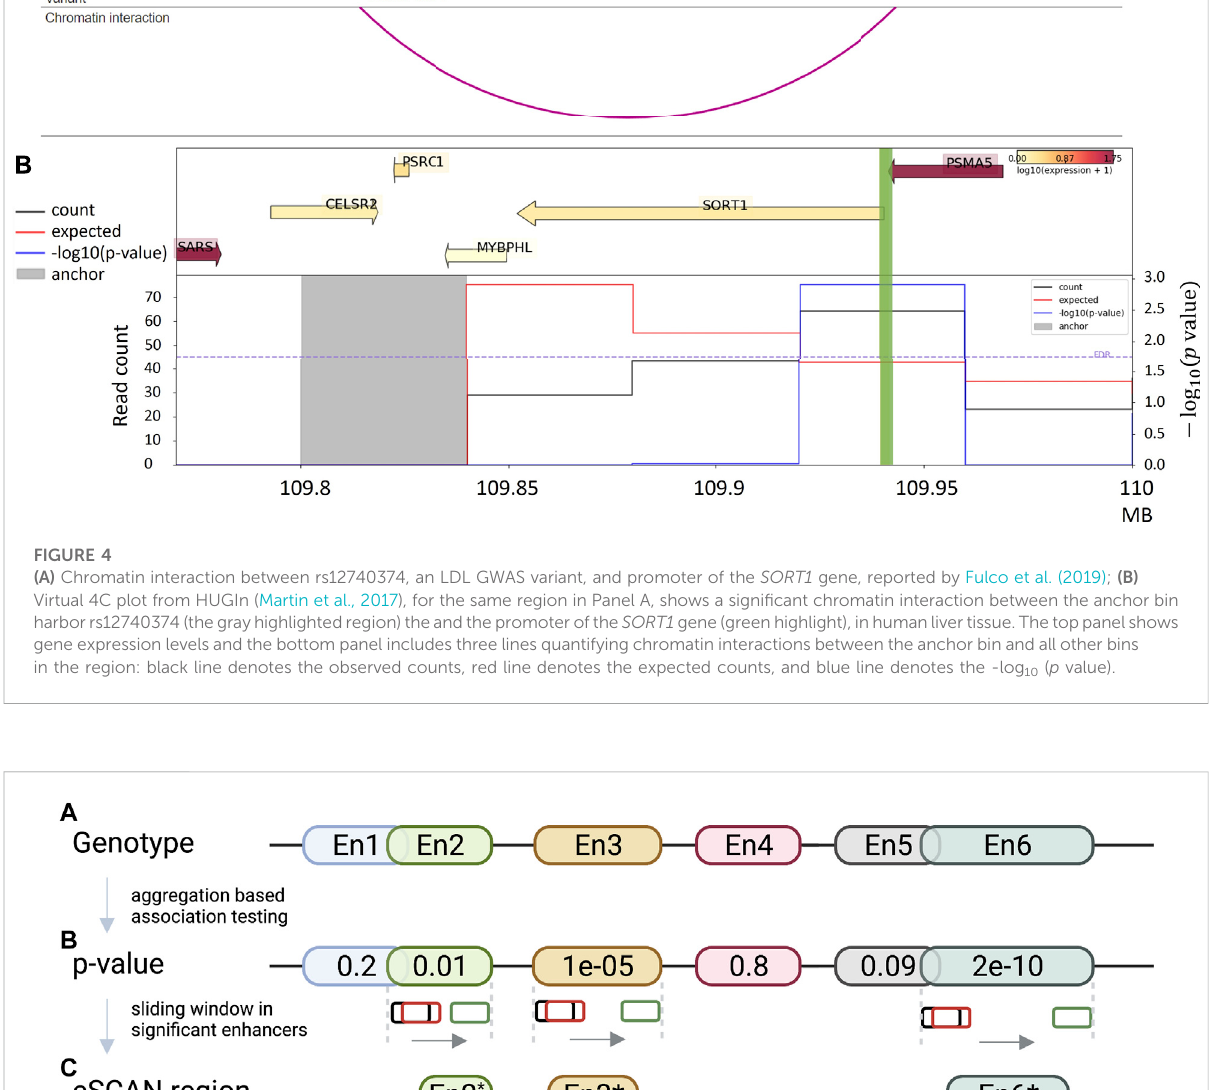
(Wu and Pan, 2019) method performs a gene-based aggregation association test by integrating enhancer-promoter interactions and methylation QTLs with GWAS summary statistics. E + G + Methyl gains statistical power to detect target genes for GWAS